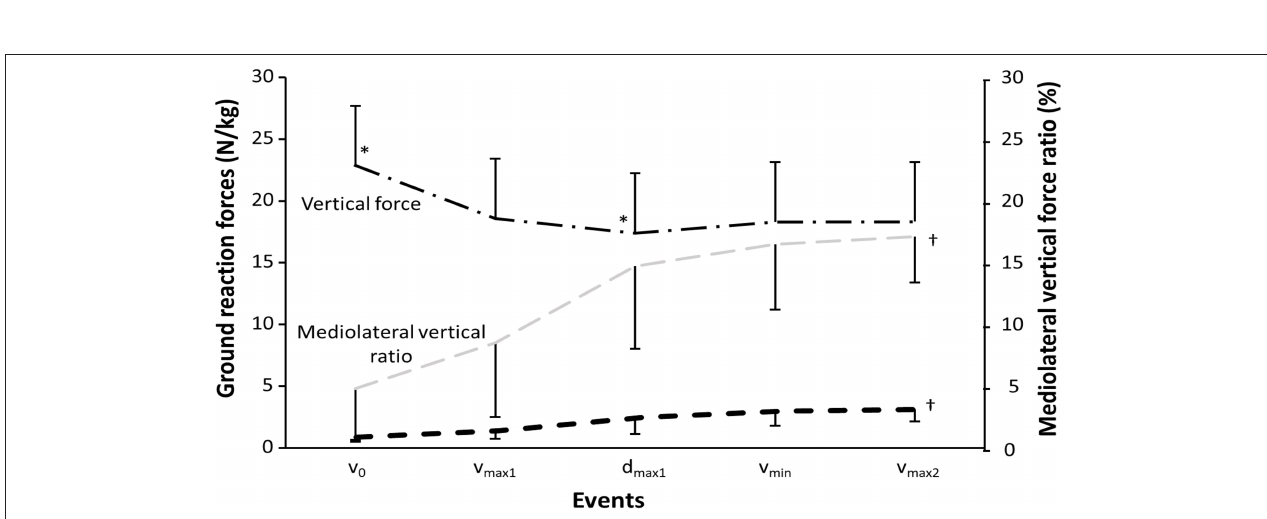
FIGURE 3 | Mean ± SD vertical and horizontal ground reaction forces together with mediolateral to vertical force ratio. * indicates a significant difference with all other events on a p ≤ 0.05 level. † indicates a significant difference between all events for this variable on a p ≤ 0.05 level.